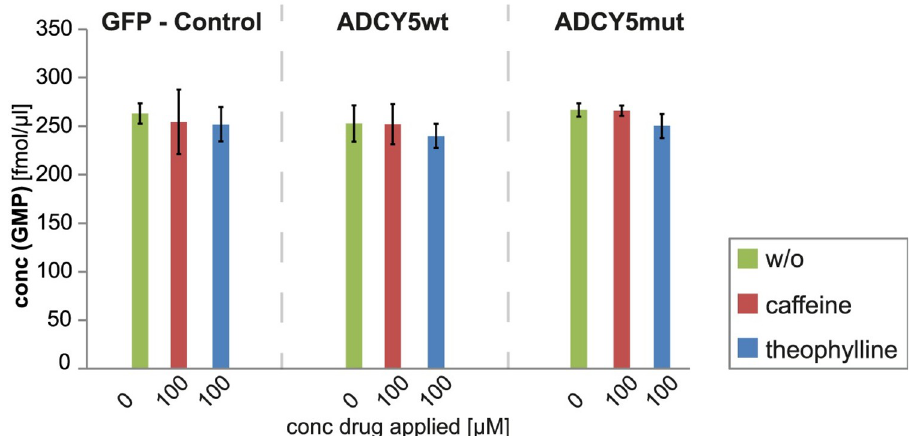
Fig 5. Influence of caffeine (red bars) and theophylline (blue bars) at a concentration of 100 μ M on GMP levels of different cell lines, 1 h drug treatment. Controls without drug treatment are shown as green bars. Experiments were performed in 3